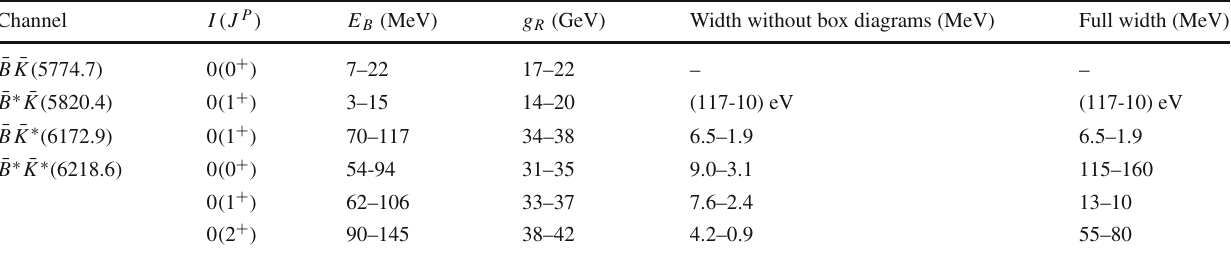
Table1 Resultsforthebindingenergy, E B ,coupling, g R ,andthewidth without and with the consideration of the box diagrams of Fig. 7. The first number in the numerical cells represent the value obtained with the